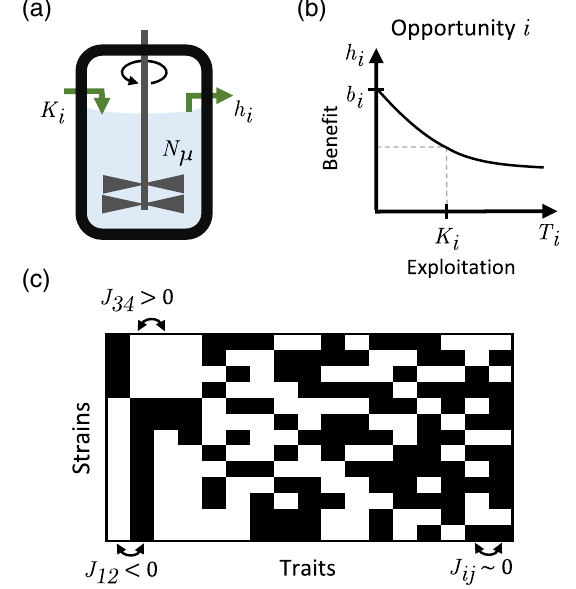
FIG. 1. Our ecoevolutionary framework modifies a standard model of resource competition. Organisms engage in ecological competition for limited resources and evolve by gaining or losing traits. Carrying a trait incurs a cost but enables the organism to benefit from the corresponding resource. Here, our novelty is to consider how traits interact with each other. Combinations that interact unfavorably are costly to maintain; as a result, not all phenotypes are competitive. (a) A metabolic interpretation of our model corresponds to an ecosystem in a chemostat. A set of strains with abundances f N μ g compete for a set of substitutable resources indexed by i , e.g., alternative sources of carbon. In this interpretation, K i correspond to resource supply rates, and h i are the resource concentrations in the effluent. (b) For this work, we adopt a more general interpretation where the resources i need not be specifically metabolic. Instead, we think of i as enumerating any depletable environmental opportunities that the phenotypes can exploit, which confer a benefit h i that declines with exploi- tation level T i . We parametrize this dependence by the maximum benefit b i and the carrying capacity K i (the exploitation level where the benefit is halved); see the text. (c) In our model, phenotypes are binary vectors described by traits they carry. The most competitive phenotypes (rows in the cartoon) are not random but are shaped by pairwise trait interactions J ij . Strongly synergistic traits ( J ij > 0 ) tend to cooccur, while strongly antagonistic traits ( J ij < 0 ) are likely not carried together. Such structured phenotypes lead to structured ecosystems, as we